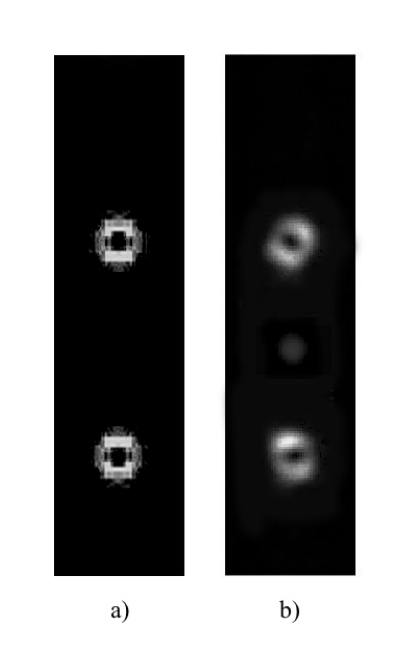
Figure 3. Far-field diffraction patterns of fork grating. ( a ) Simulated diffraction pattern; ( b ) experimental diffraction pattern recorded by CCD